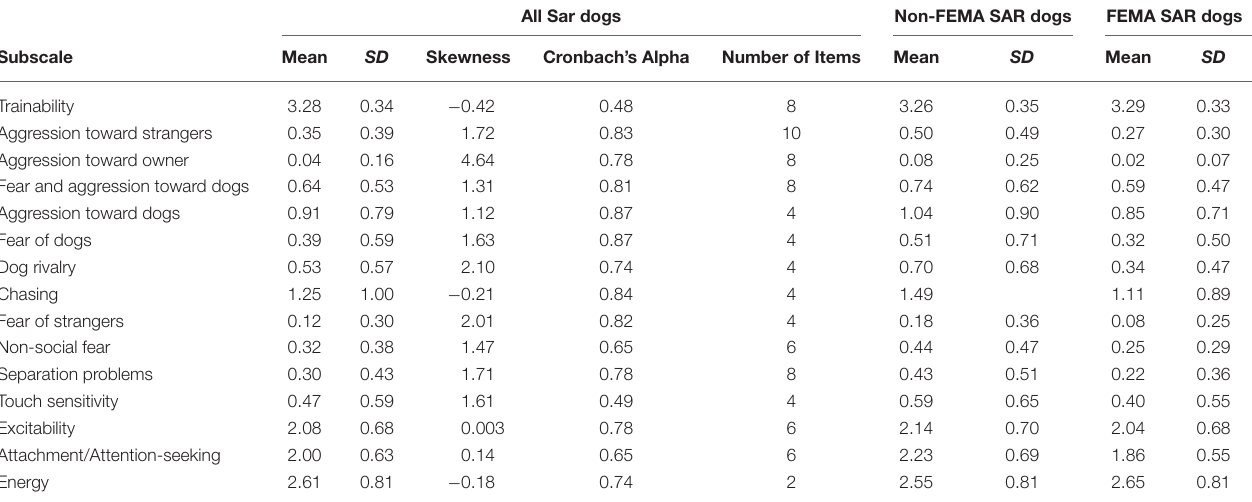
TABLE 2 | Descriptive statistics for C-BARQ subscales.